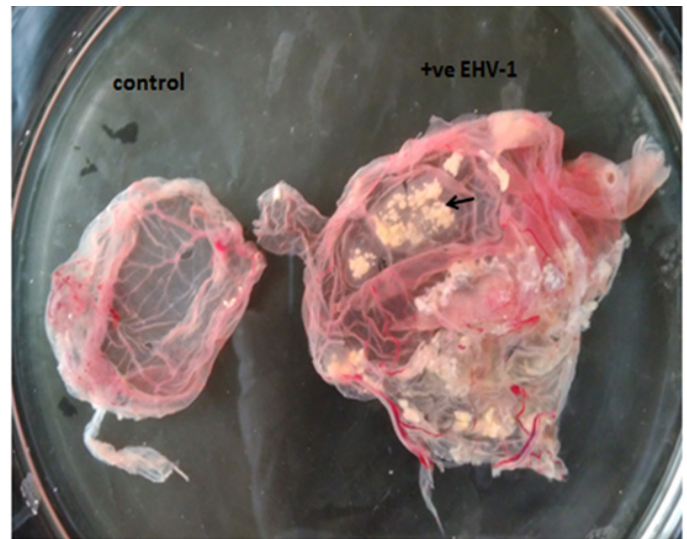
Figure 1. CAM of embryonated chicken egg (3 rd passage) showing pock lesion which represented by grayish or yellowish necrotic areas